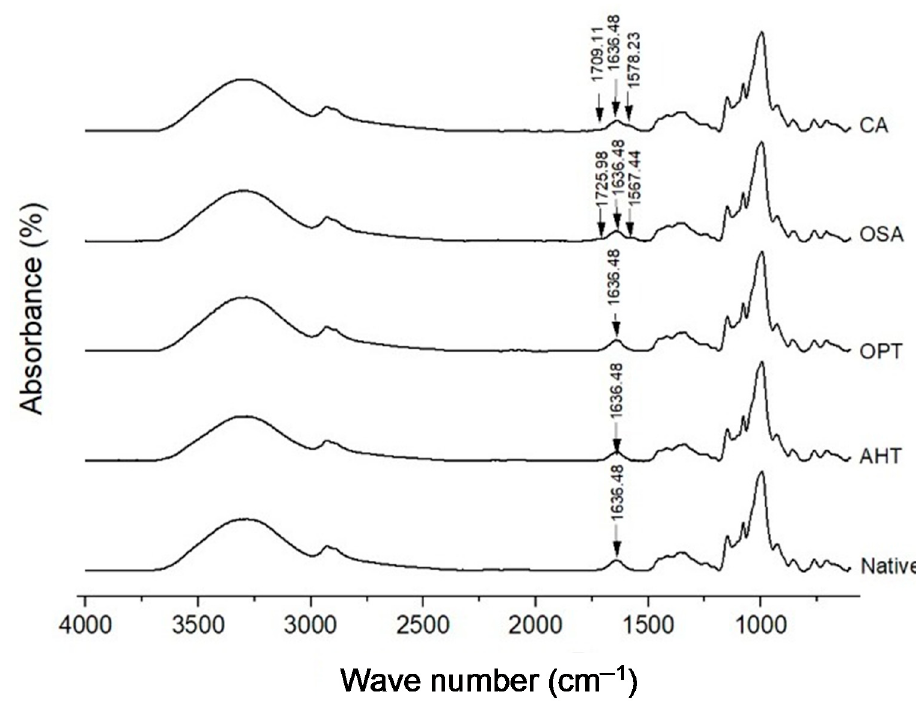
Figure 4. FTIR spectra of native and various modified sago starches. AHT = autoclave-heating treatment, OPT = osmotic-pressure treatment, OSA = octenyl-succinic anhydride, CA = citric-acid cross- linking.